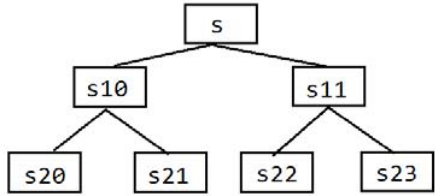
Figure 13. Wavelet packet decomposition. S is the original signal, s10 is the first signal of Layer 1 decomposition and s20 is the first signal of Layer 2 decomposition.